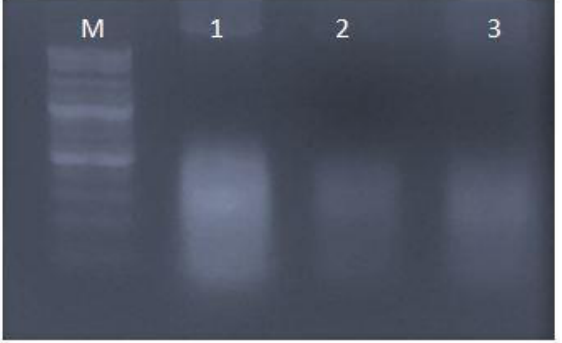
Fig. 1. Fragmented DNA on 2% agarose gel ladder; lane 1: C group; lane 2: DLM group; Lane 3: DLM + WGO